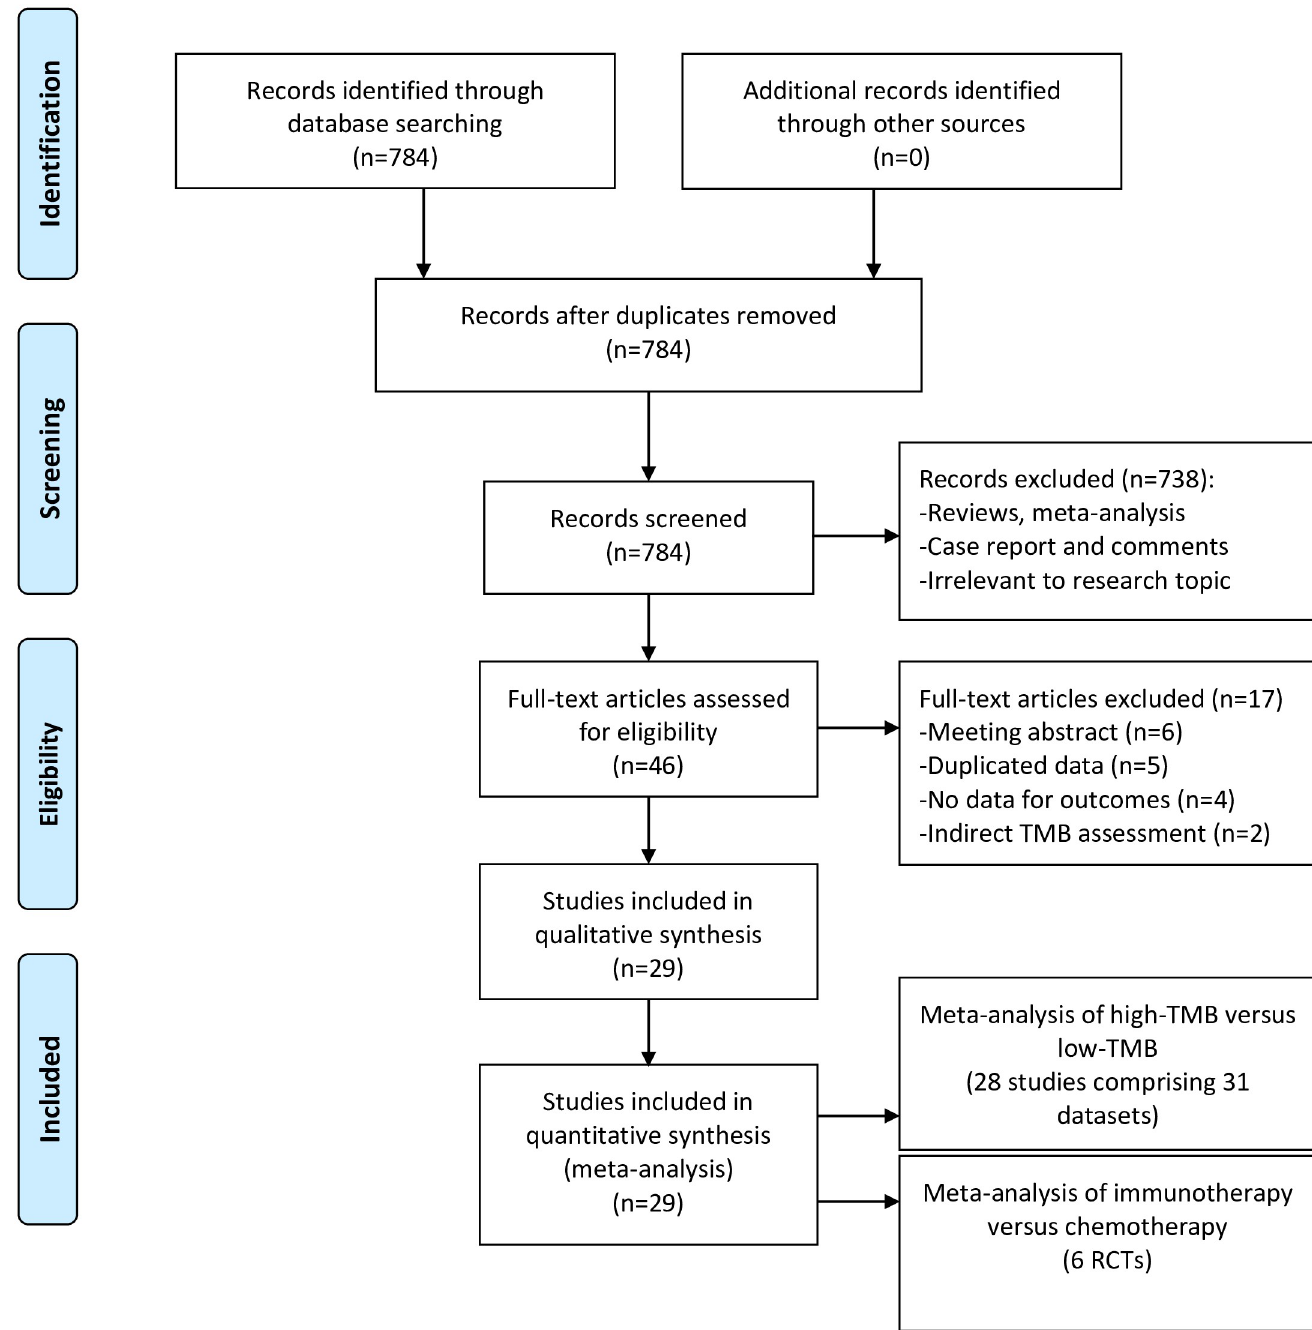
Fig 1. Flowchart of literature search.